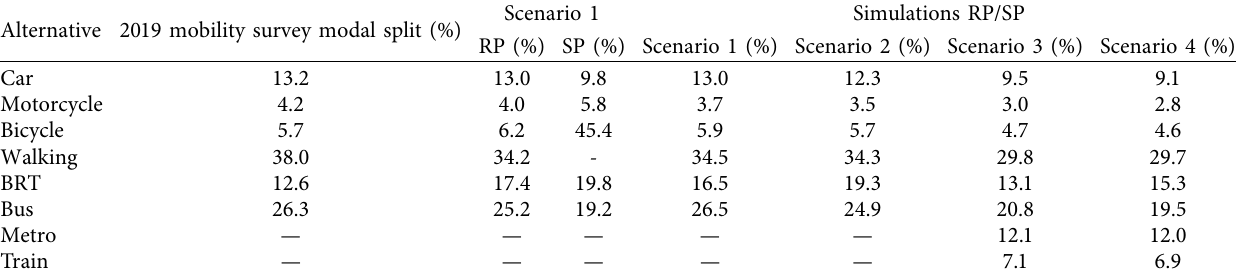
Table 8: Market shares by scenario. Scenario 1 Simulations